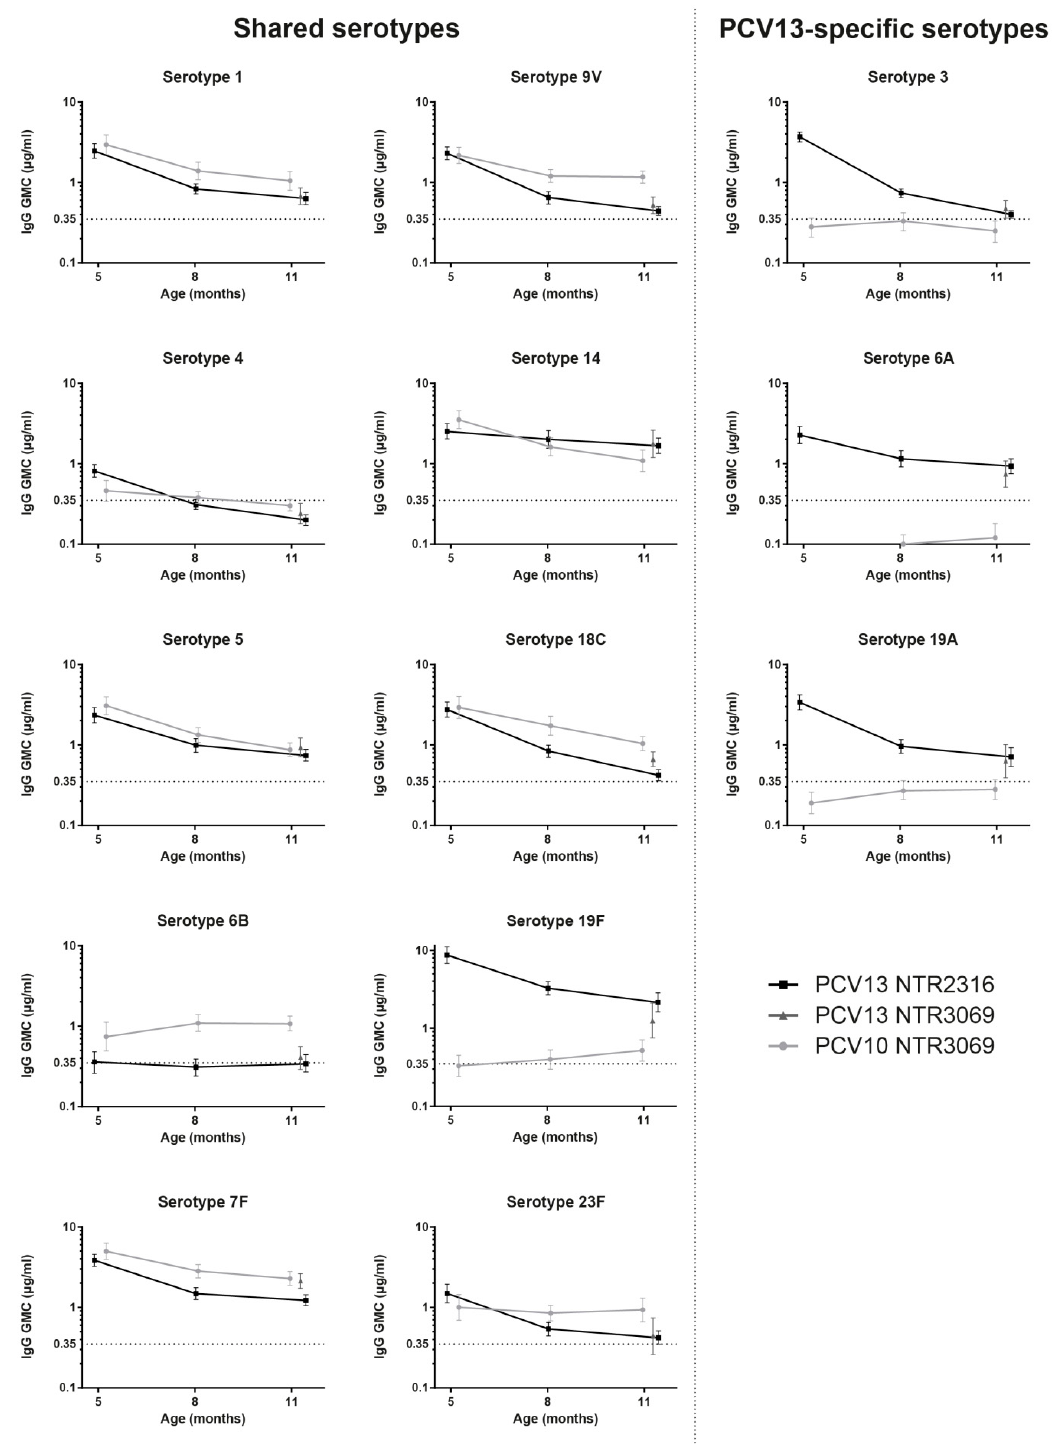
Figure 2. Serotype-specific IgG concentrations at 5, 8, and 11 months of age. IgG levels were expressed as geometric mean concentrations (GMCs) with 95% CIs of infants vaccinated with PCV10 or PCV13. Age at blood sampling was set as a continuous variable. For serotype 6A, the GMC was 0.06 µ g/mL at 5 months in the PCV10 group.